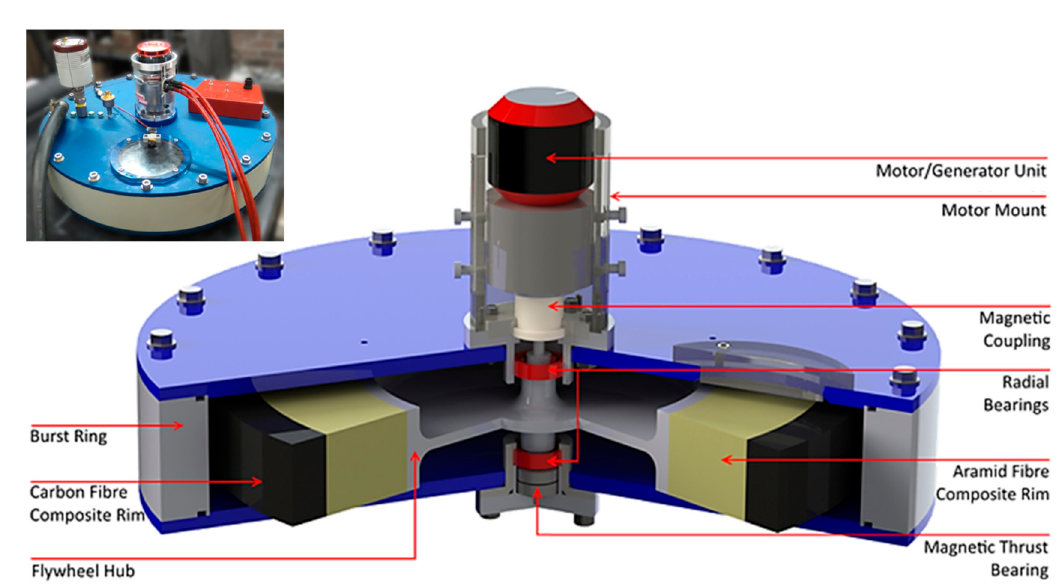
Figure 1. Flywheel energy storage device used in this study: cut-away view with labeled primary components and inset showing a photograph of the actual device.